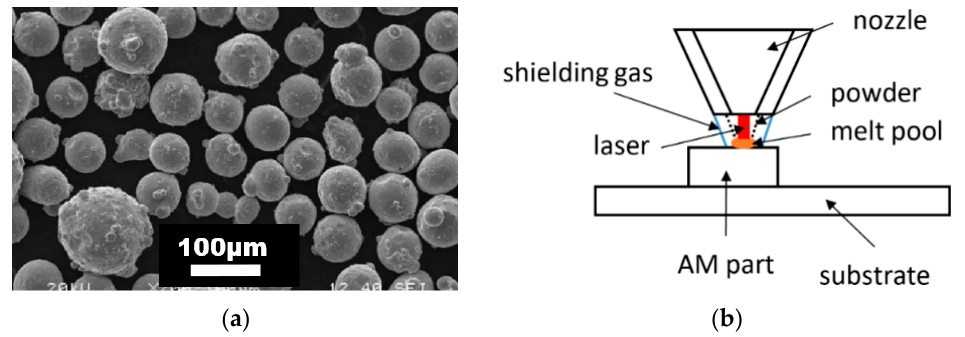
Figure 1. ( a ) CAD model of honeycomb design using SolidWorks (SHORT—height of 28 mm) with the dimensions of the build captured, ( b ) DED-processed sample—LONG (height of 42 mm) and ( c ) SHORT (height of 28 mm).